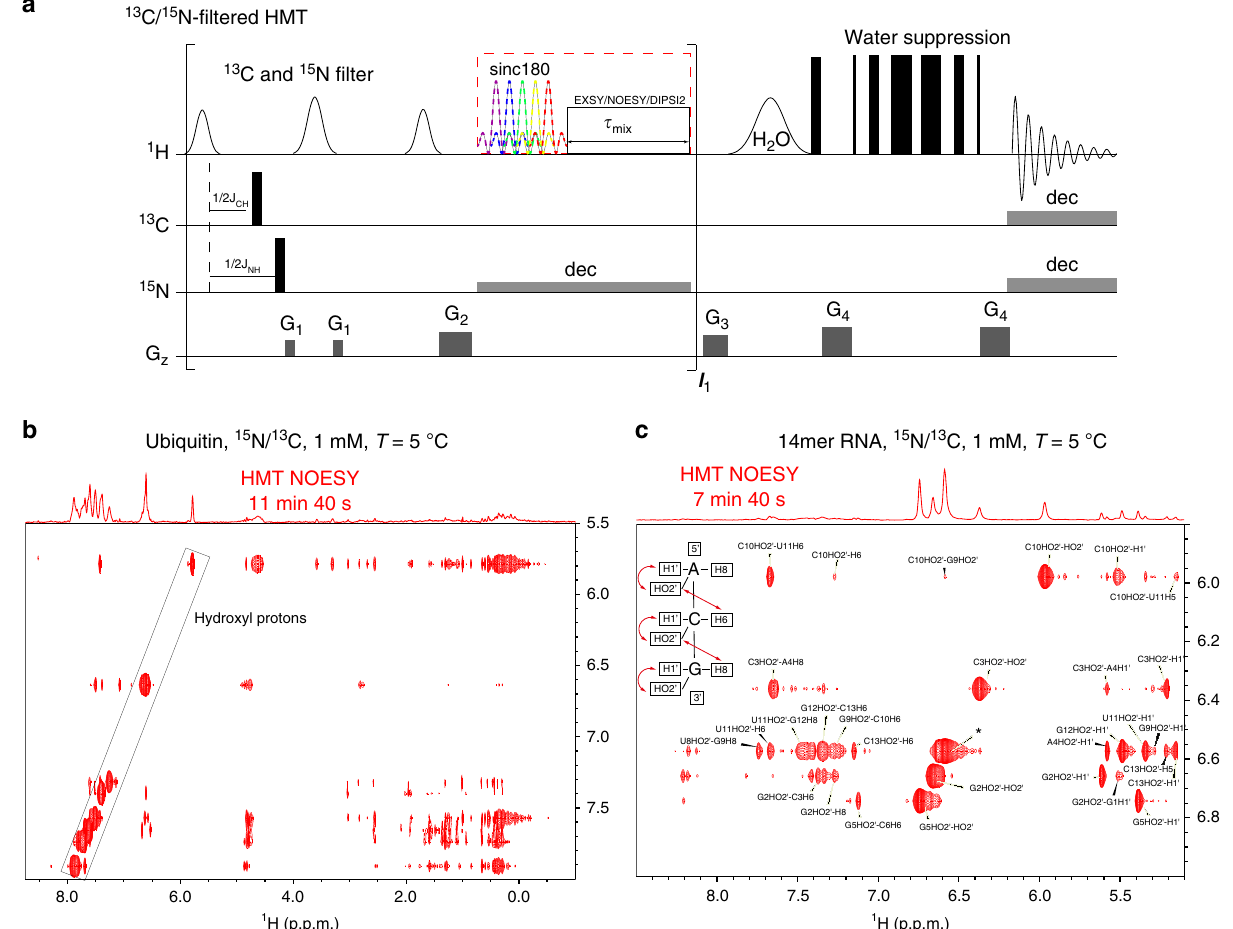
Fig. 6 HMT incorporating a fi lter to suppress 1 Hs bound to 13 C and/or 15 N in labeled compounds, in order to selectively observe “ hidden ” hydroxyl hydrogens. a Pulse sequence incorporating a fi lter is applied at the beginning of every loop in order to prevent the suppressed 13 C- and/or 15 N-bound 1 Hs to start recovering during mixing periods. Consequently, short mixing times have to be used per loop; this is not a hindrance in this case thanks to the OH ’ s fast chemical exchange with water. In the illustrated fi lter, a selective 1 Hs spin-echo is applied only to the HO-bearing regions, so as not to disturb other 1 Hs that maybe receiving the magnetization from these targeted sites. Examples are illustrated with b ubiquitin acquired using 10 loops and 50 ms per loop, and c the 14mer RNA using 15 loops and 40 ms mixing time per loop. The structure in the inset illustrates the latter ’ s expected NOE correlations involving hydroxyl 1 Hs, and a nearly complete assignment of these resonances revealing the many long-range correlations provided by the HMT spectrum. Resonances labeled with an asterisk does not have unambiguous assignment, as they involve 4 or 5 overlapping hydroxyl 1 Hs. Spectra were acquired at 1 GHz using a Bruker Avance Neo console equipped with a TCI